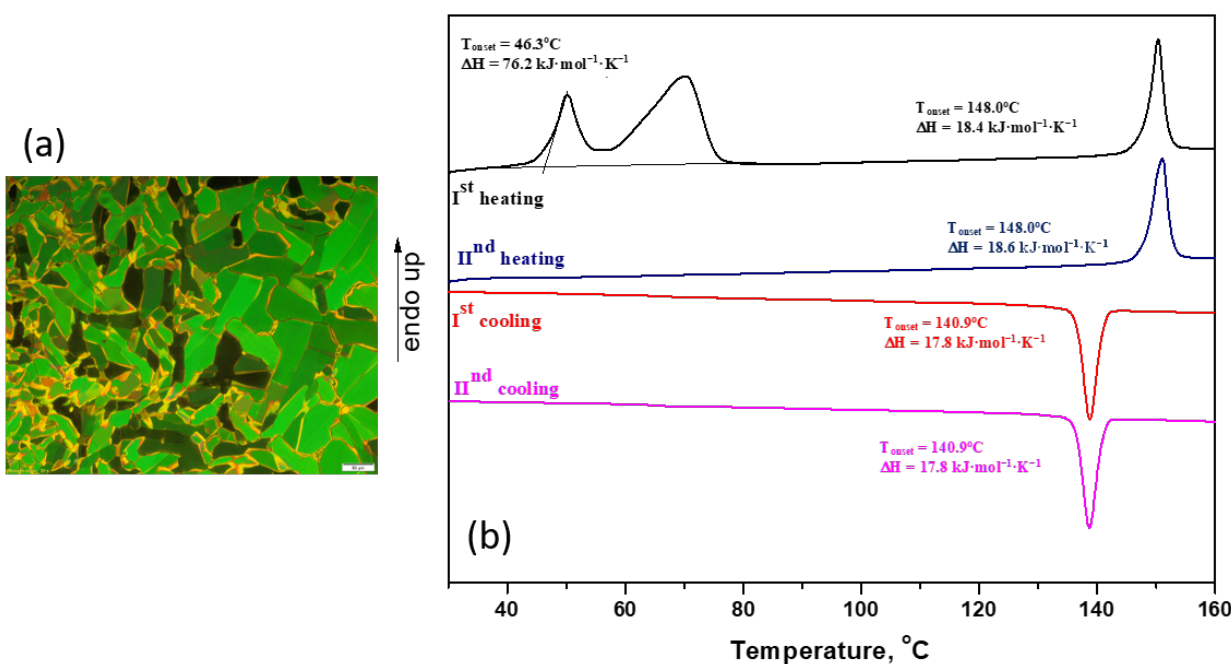
Figure 2. ( a ) POM texture of Zn/Fe upon first cooling at 50 °C (magnification 20×); ( b ) DSC traces of complex Zn/Fe .